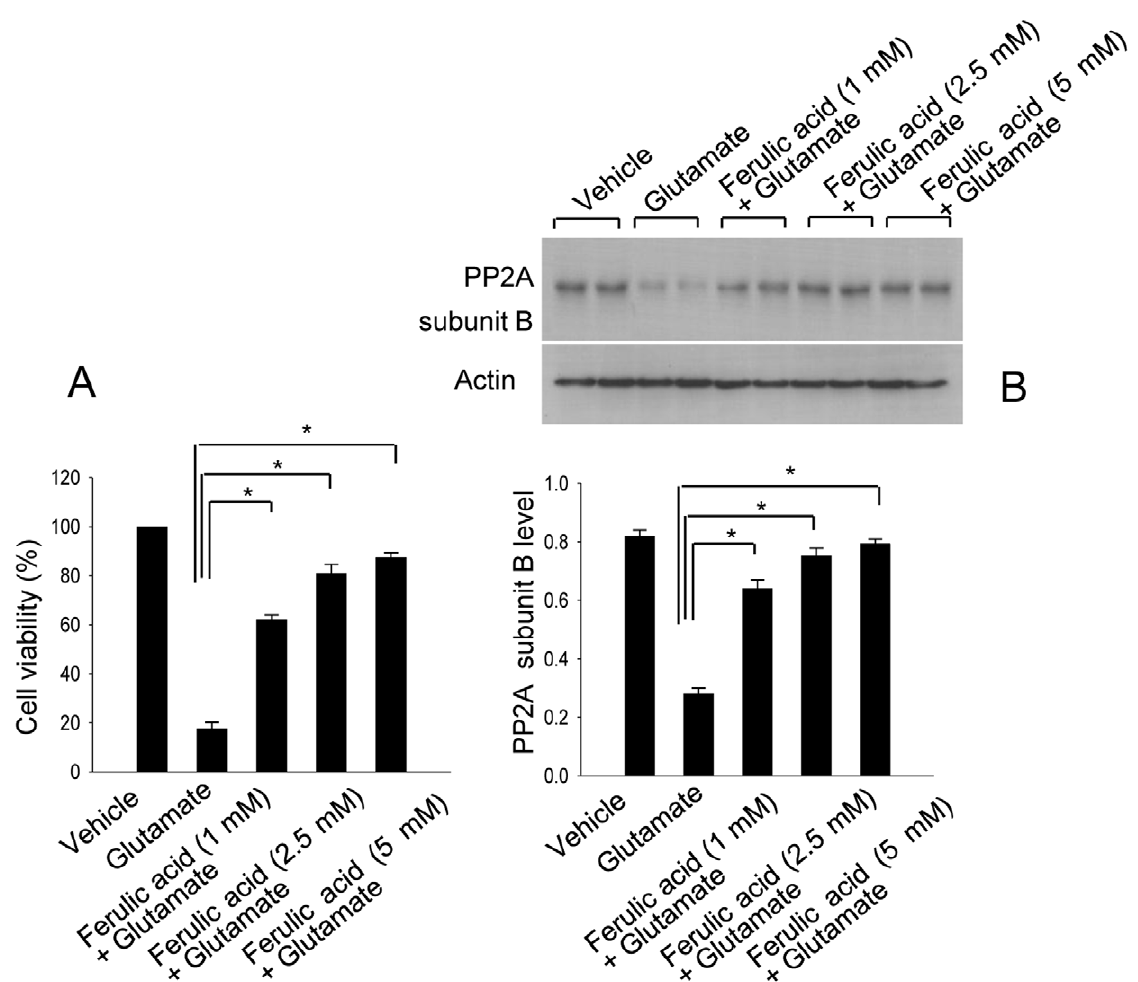
Figure 6. The neuroprotective effect of ferulic acid and protein phosphatase 2A (PP2A) subunit B protein expression in HT22 cells. Cell viability (A) and Western blot analysis of protein phosphatase 2A (PP2A) subunit B (B) in HT22 cells. Glutamate (5 mM) was exposed to HT22 cells for 24 h and ferulic acid (1, 2.5, 5 mM) was treated at 30 min before glutamate exposure. Cellular viability was assessed using the MTT assay (A). Cell survival was expressed as percentage of neuroprotection vs. vehicle set at 100%. Densitometric analysis is represented as intensity of PP2A subunit B to intensity of actin (B). Data ( n =5) are represented as mean 6 S.E.M. * P , 0.05.